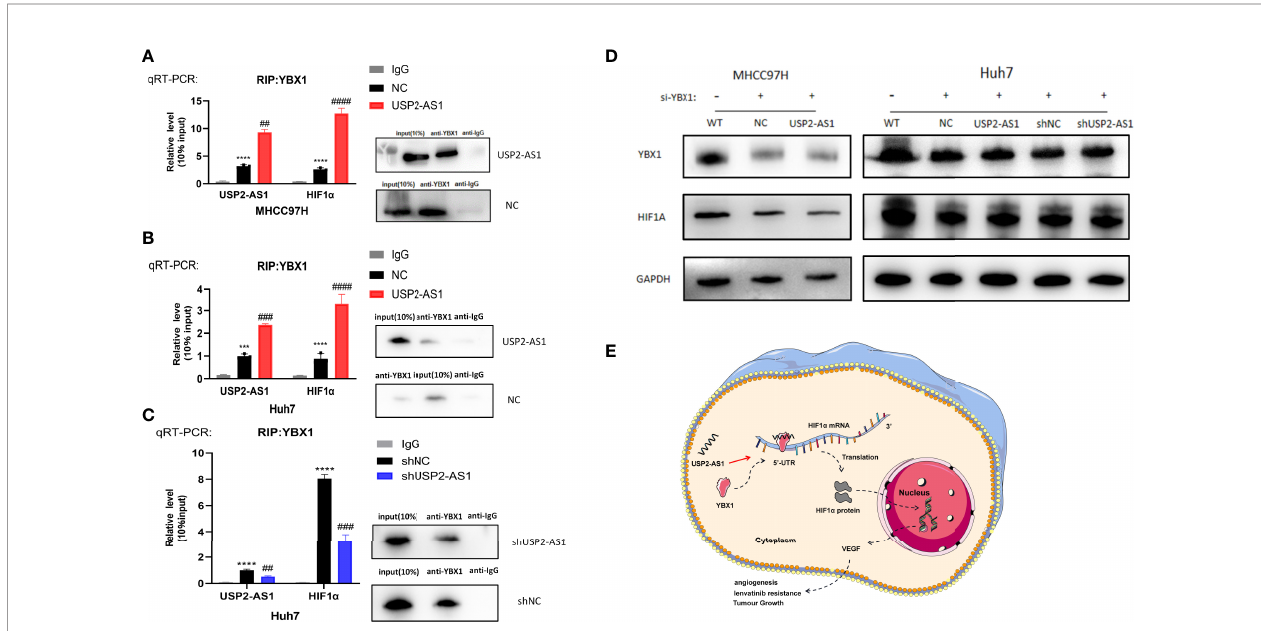
FIGURE 5 | USP2-AS1 enhances YBX1 protein binding to HIF1 a mRNA under hypoxic conditions. (A) RIP assays were performed to con fi rm that USP2-AS1 overexpression in MHCC97H can increase the effective binding of YBX1 to HIF1 a mRNA. (B) RIP assays showed that USP2-AS1 overexpression in Huh7 increases the binding of YBX1 protein to HIF1 a mRNA. (C) USP2-AS1 knockdown in Huh7 signi fi cantly inhibits the binding of YBX1 protein to HIF1 a mRNA by RIP assays. HIF1 a mRNA and USP2-AS1 were measured by RT-qPCR after RIP. WB assays were performed to test the experiment quality (10%input used as a positive control and IgG was the negative control). (D) WB assays were performed to analyze the effect of USP2-AS1 on HIF1 a protein in MHCC97H and Huh7 after YBX1 was knocked down by siRNA, GAPDH as protein loading controls, WT as the controls. (E) The possible mechanism of USP2-AS1 regulating HIF1 a protein translation by YBX1 under hypoxia in HCC, ## p < 0.01, and *** or ### p < 0.001, **** or #### p <